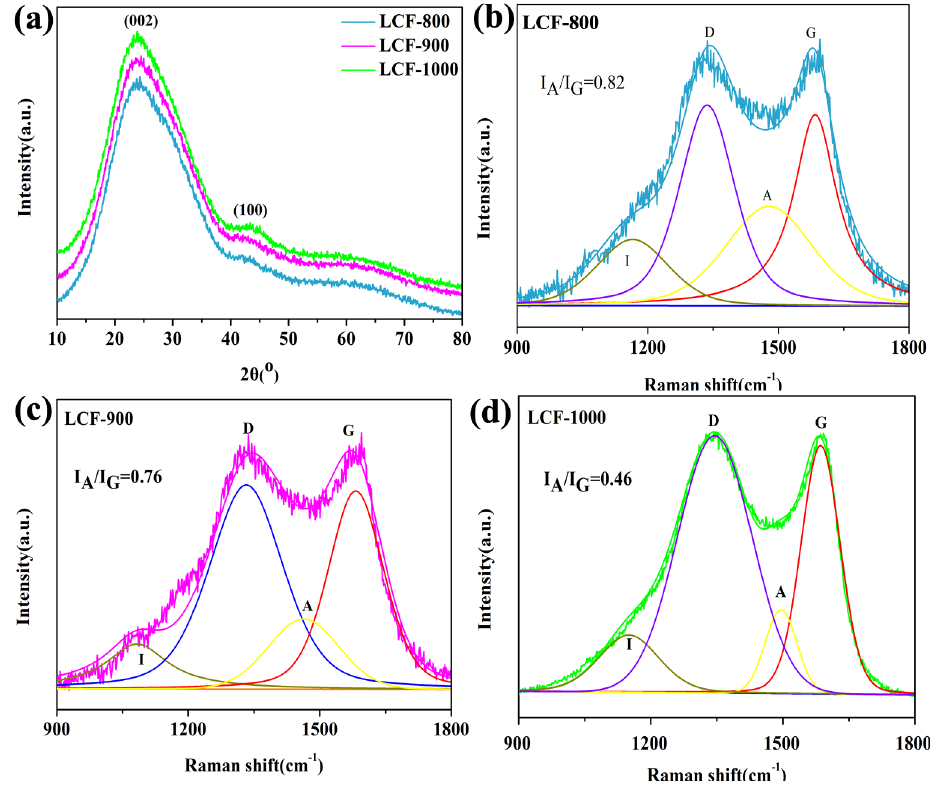
Figure 2. XRD spectra of the LCF mats ( a ); Raman spectra of LCF-800 ( b ), LCF-900 ( c ), and LCF-1000 ( d ).